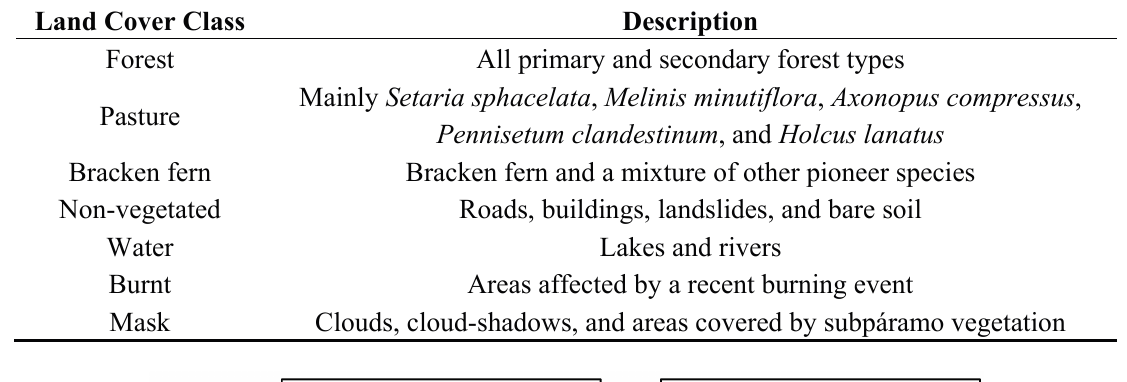
Table 4. Land cover classes.